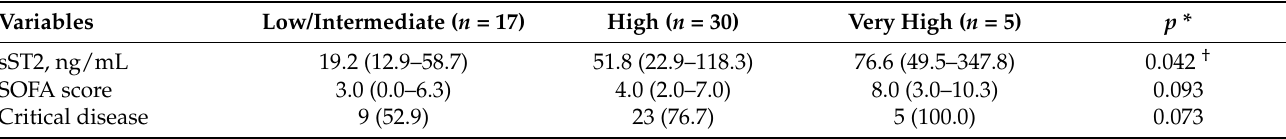
Table 3. sST2, SOFA score, and critical disease according to 4C mortality score risk group.